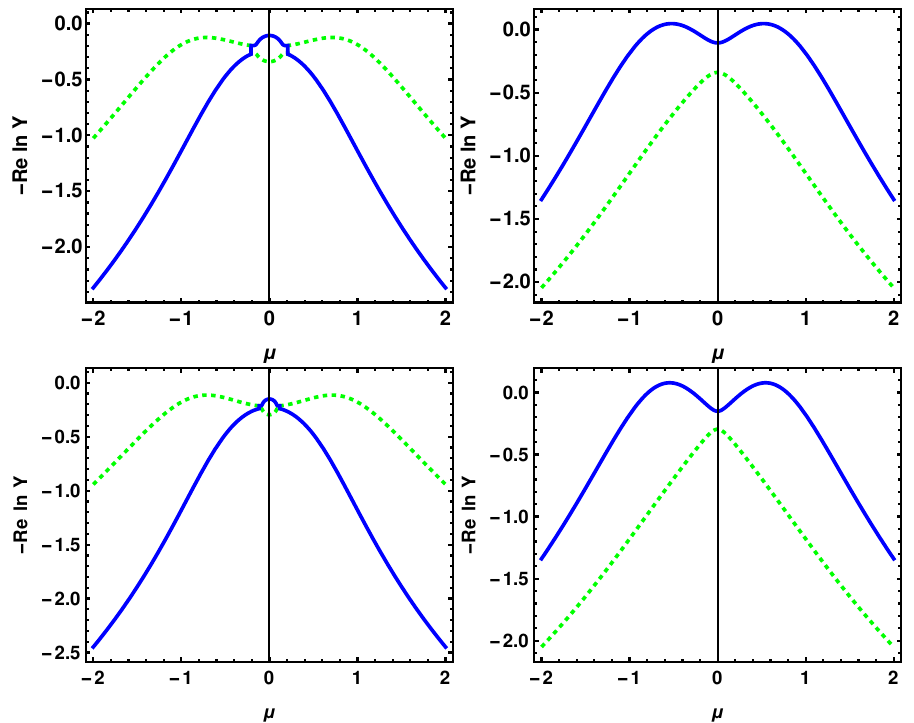
Figure A1. Curves of pseudocontinuous spectrum in the limit of large delay (21) of (12) of the CW with the lowest intensity A 0 = η √ for ζ = π , η = 1.285 ( top ) and the largest intensity (A13) for 2 1 + κ ζ = π /6, η = 0.975 with β = − 0.3 ( top-left ), β = 0.3 ( top-right ), β = − 0.1 ( bottom-left ) and β = 0.1 √ ( bottom-right ). Other parameters are κ = 0.8, σ = 2.5, α =